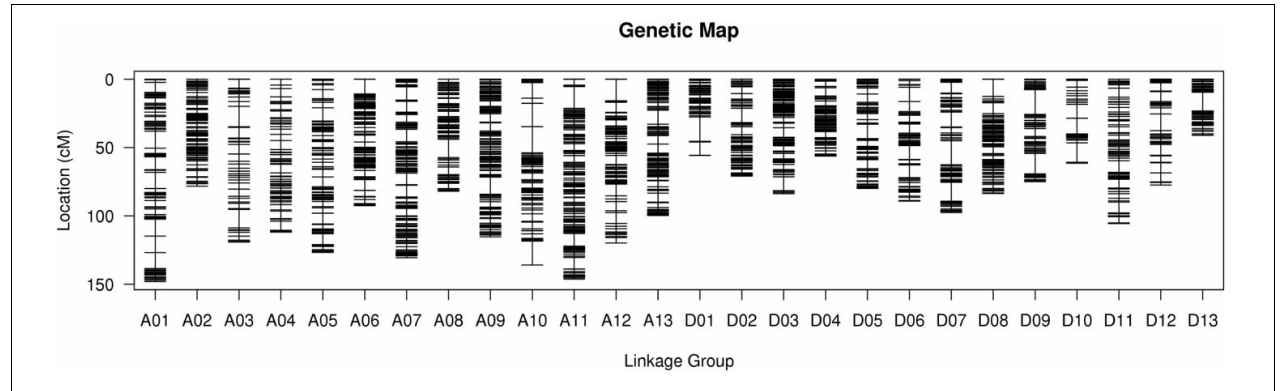
FIGURE 2 | The distribution of SNP markers in the 26 linkage groups/chromosomes.